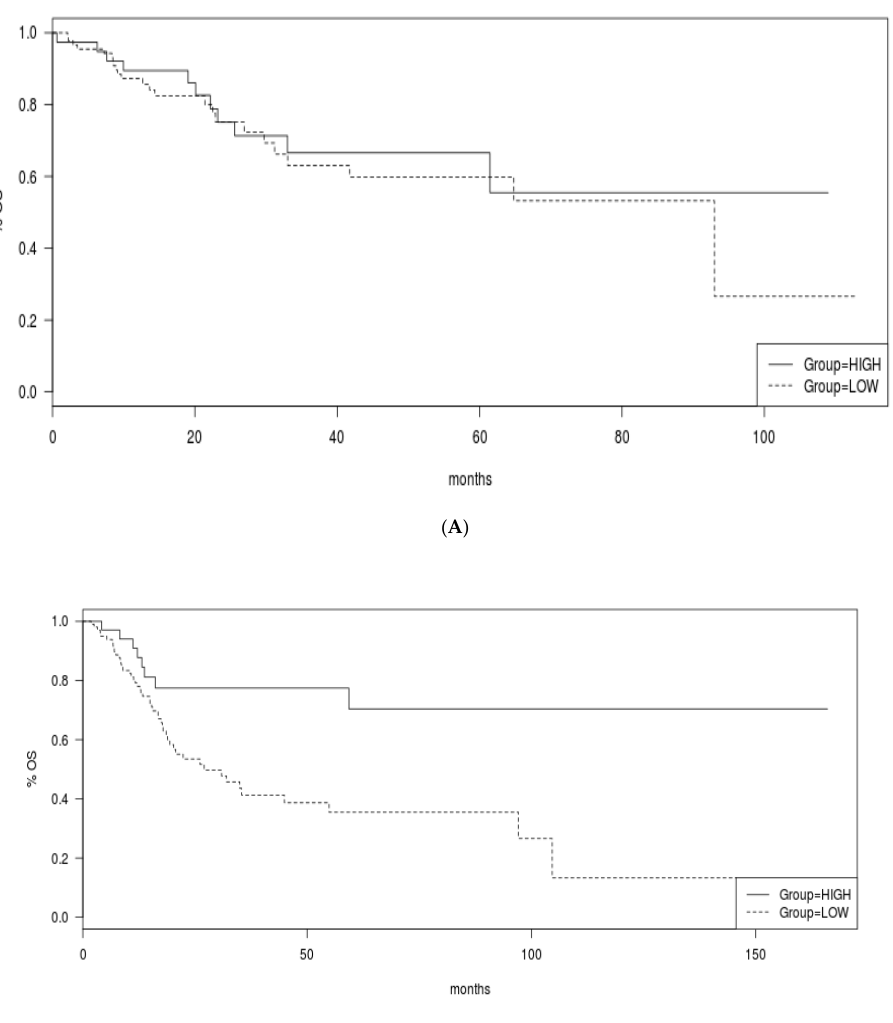
Figure 9. ( A ) Overall survival and ( B ) Disease Specific Survival of the high and low TMB groups.